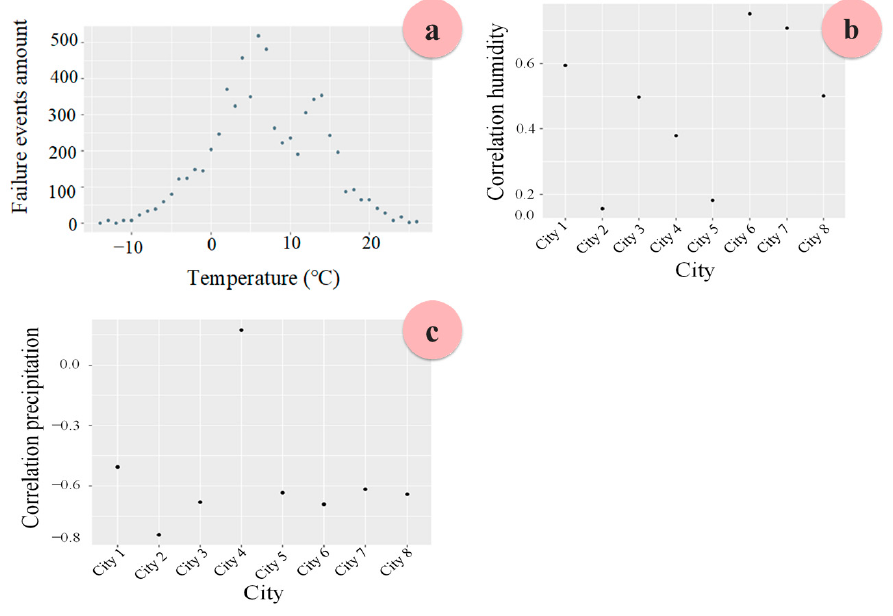
Figure 13. Analysis of external data including ( a ) failure events versus temperature ( b ) humidity versus city ( c ) precipitation versus city.